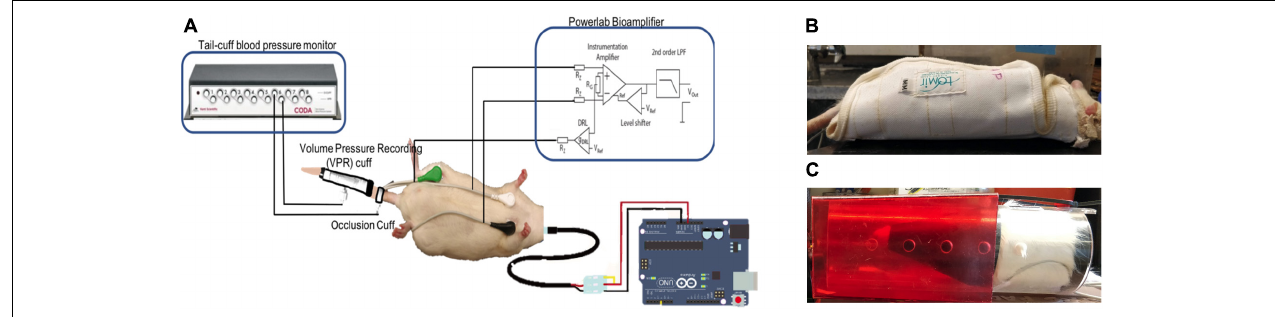
FIGURE 1 | (A) Schematic of the sensors. Noninvasive electrodes placed on the ventral skin surface of a rat in Lead I configuration, the Coda R (cid:13) Blood Pressure system with occlusion and VPR cuff and a temperature probe connected to an Arduino R (cid:13) . Rats restrained in (B) Lomir R (cid:13) “cuddle” jacket and (C) Plexiglass tube to restrain the animal during data